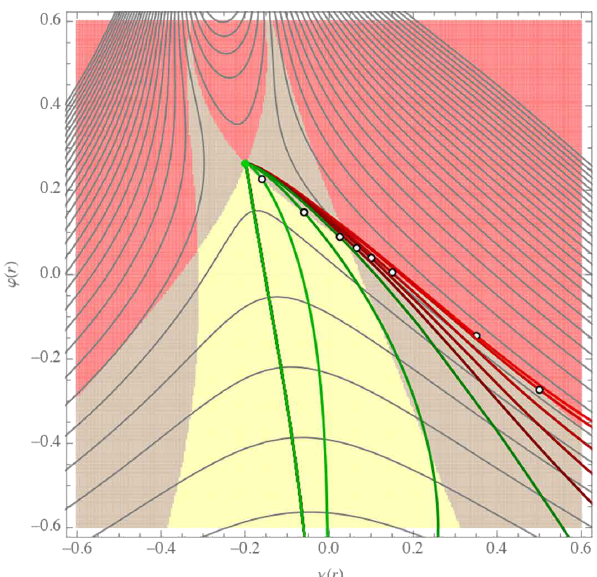
Figure 8. Space of solutions for G 2 symmetric Janus solutions with the turning points on the boundaries between yellow and grey regions and between red and grey